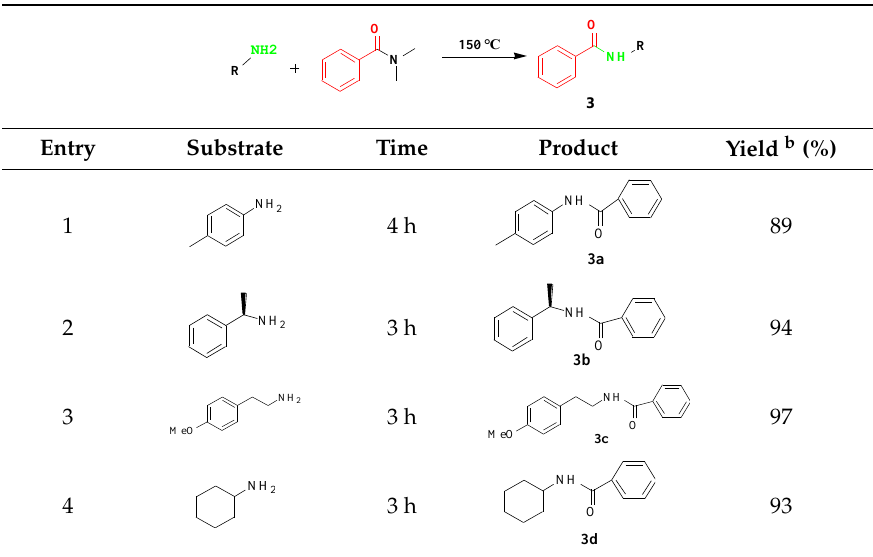
Table 4. N -benzoylation of amines 3a – 3d a .